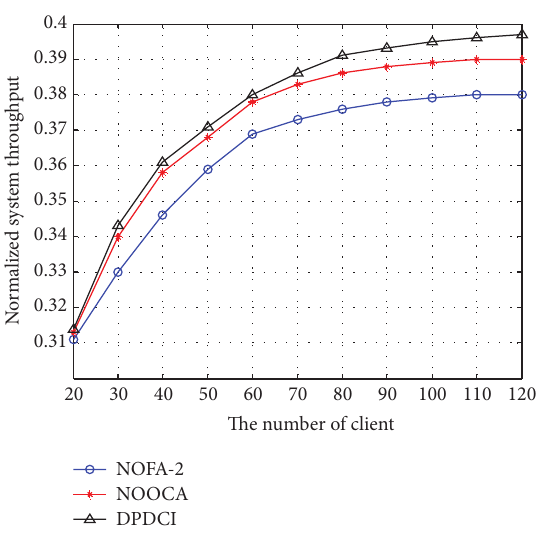
Figure 3: The comparison of average interference. Figure 4: Comparison of normalization